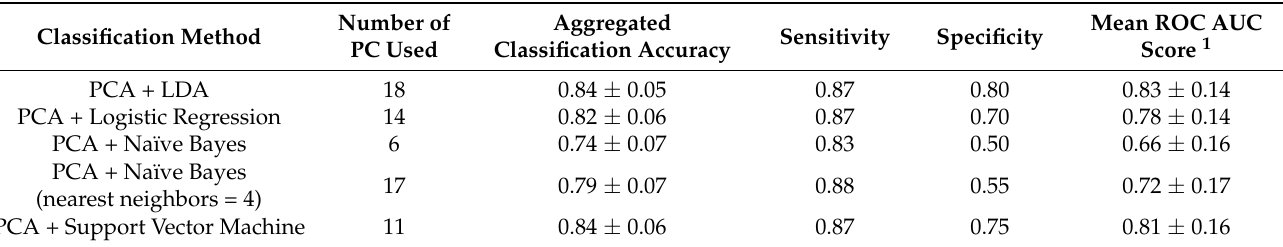
Table 1. Quantitative comparison of different binary classification methods in terms of classification evaluation metrics. Stratified K-fold (K = 10) cross-validation method was used to evaluate the aggregated metrics.